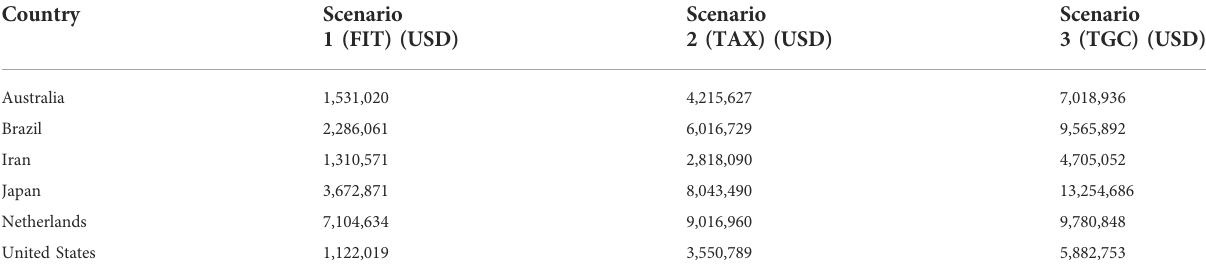
TABLE 9 Investment by InCES members. Country